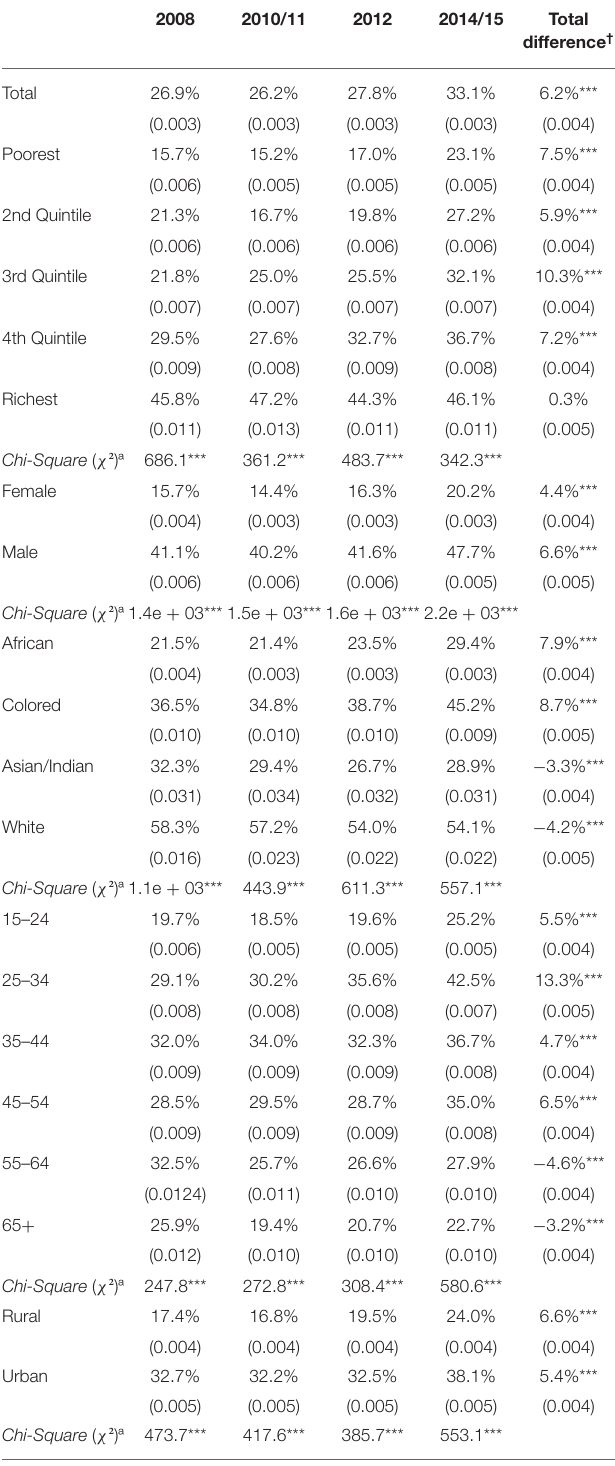
TABLE 3 | Prevalence of current alcohol drinkers in SA from 2008 to 2015 by SES and other equity